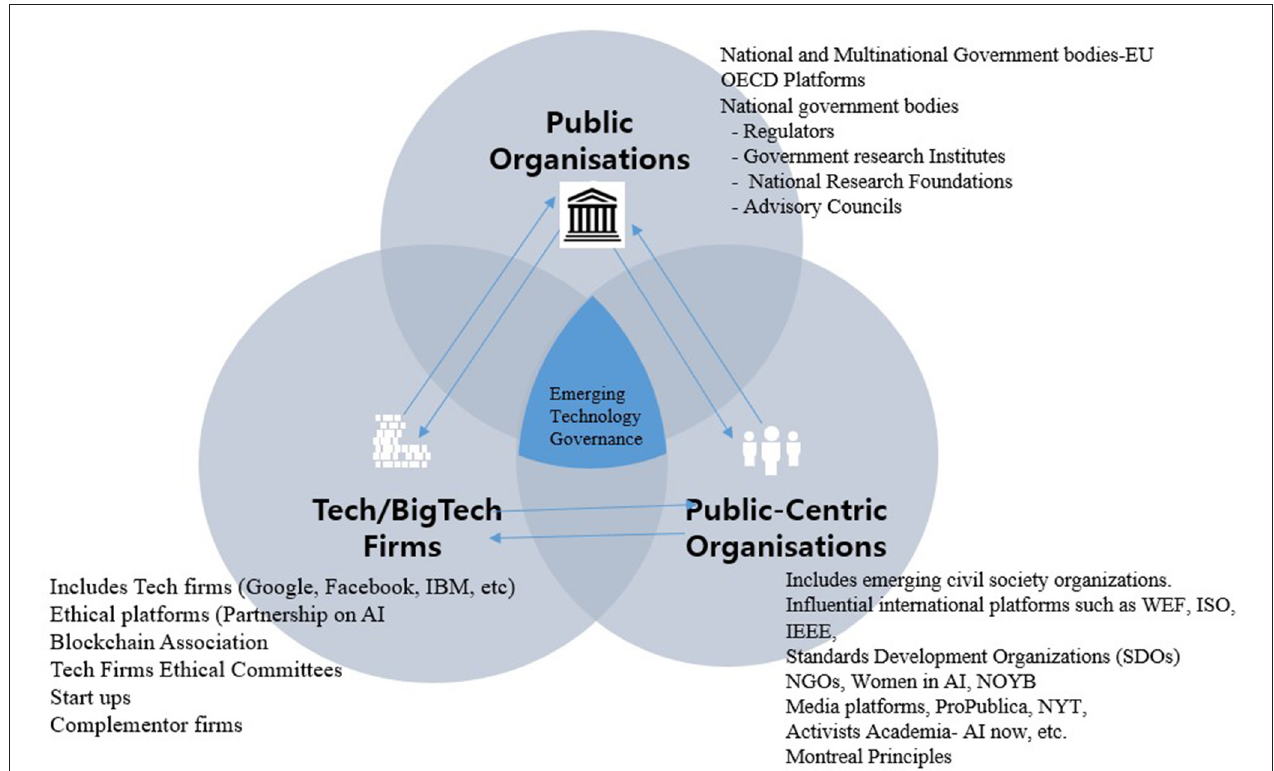
FIGURE 1 | Types of emerging technology